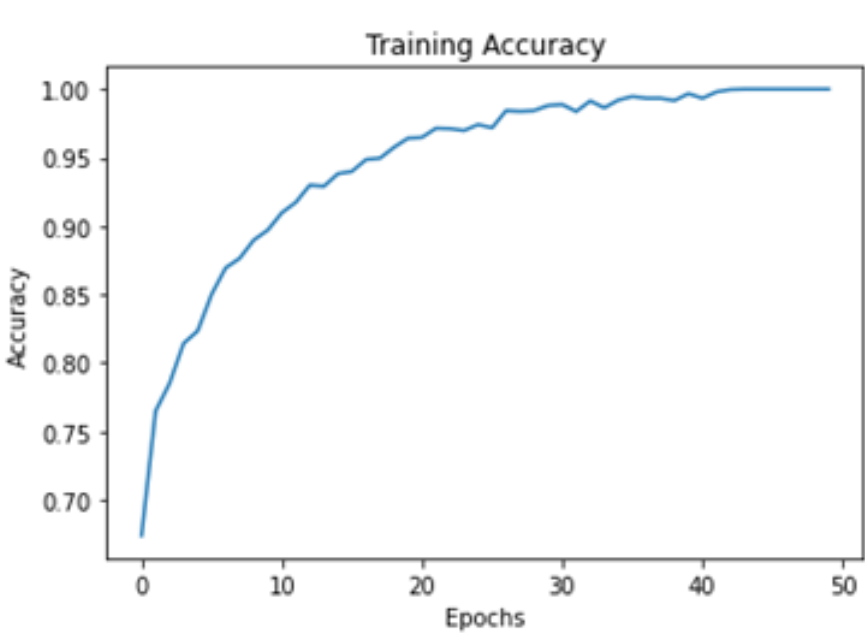
Figure 12. Model summary of the proposed model.